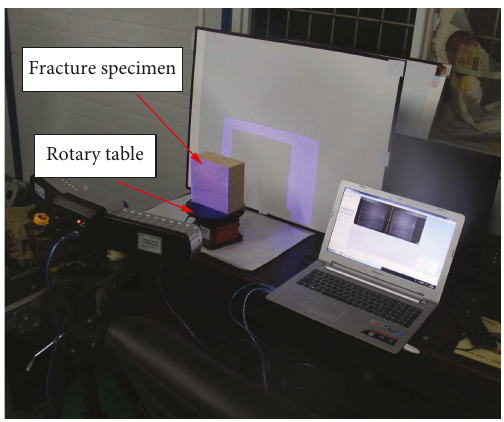
Figure 1: Stereo topometric scanning